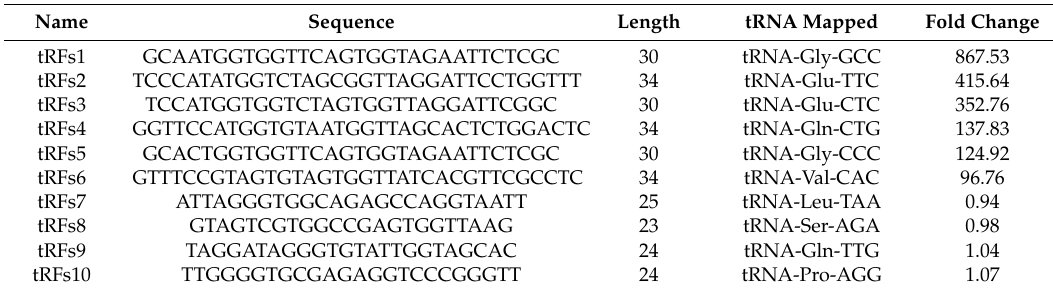
Table 1. List of some interesting tRNA fragments